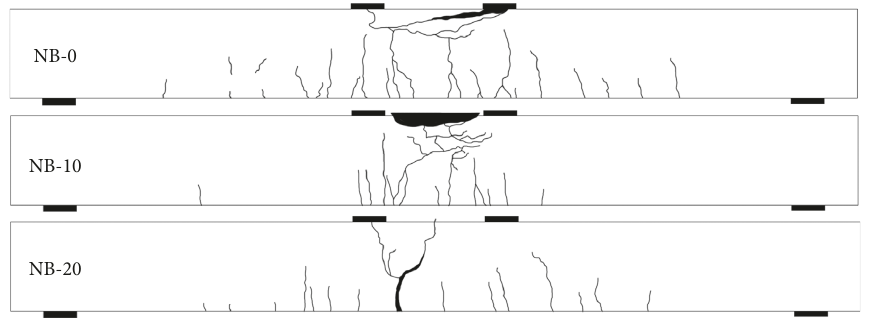
Figure 20: Crack patterns of NSC flexural